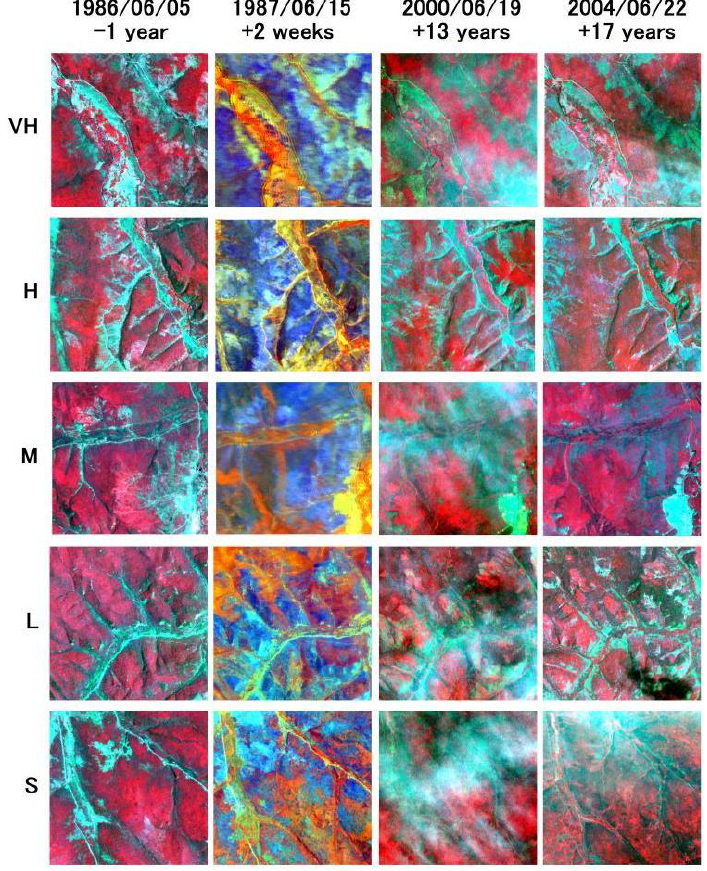
Figure 10. Landsat TM/ETM+ images (RGB:432) illustrating fire-caused changes on the ground vegetation. The locations of these five tracked simples can be found in Figure 4. Minus and plus signs represent pre-fire and post-fire period, respectively. Fire damage classes: Very High (VH); High (H); Moderate (M); Low (L); Slight